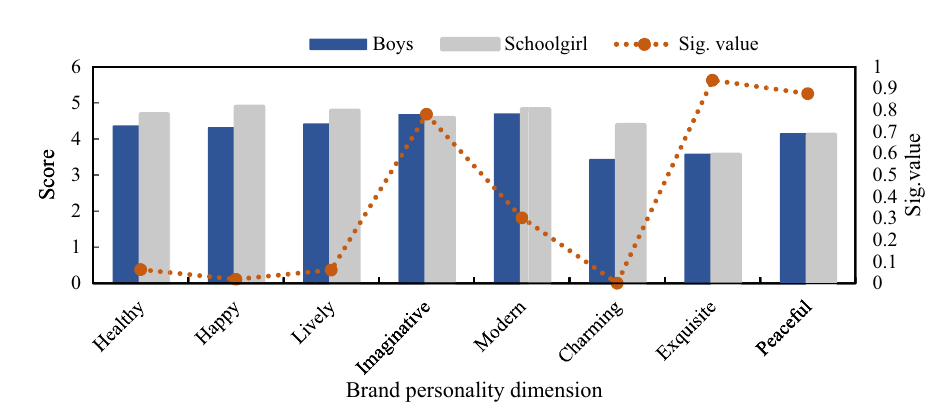
Figure 5: The eight - dimensional independent sample T test of gender and brand personality.